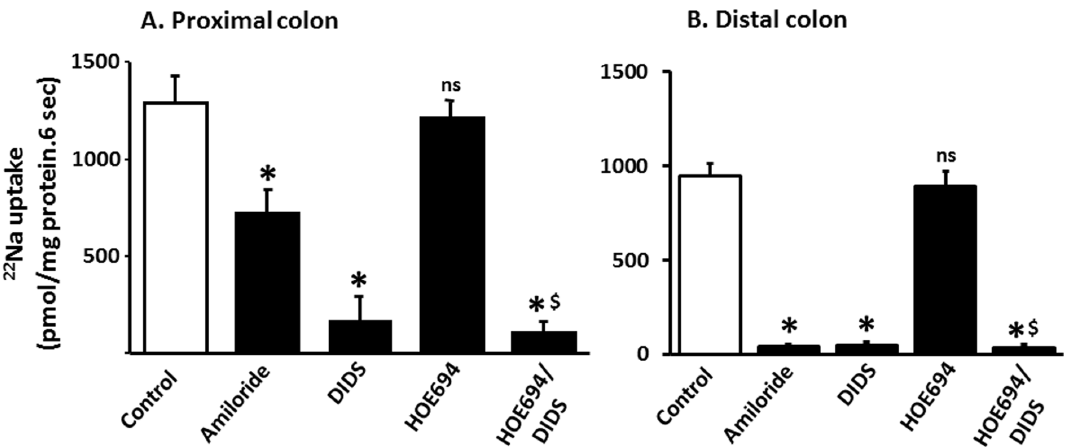
Figure 5. Effect of inhibitors on Na-HCO 3 cotransport activities in basolateral membrane vesicles from proximal and distal colon. Proton/HCO 3 gradient-driven 22 Na uptake (0.1 mM) was measured in the absence (Control) and presence of inhibitors (1 mM amiloride; 1 mM DIDS; 1 m M HOE694) in basolateral membrane vesicles (BLMV) from rat proximal [ A ] and distal [ B ] colon, as described in the method section. Amiloride partially inhibited, while DIDS almost completely inhibited the Na-HCO 3 cotransport activity in BLMV from proximal colon. Both amiloride and DIDS inhibited the Na-HCO 3 cotransport activity in BLMV from distal colon. HOE694 did not significantly inhibit Na-HCO 3 cotransport in BLMV from either proximal or distal colon. * p , 0.001 - compared to control; $ p , 0.001 - compared to HOE694; ns: not significant compared to control.